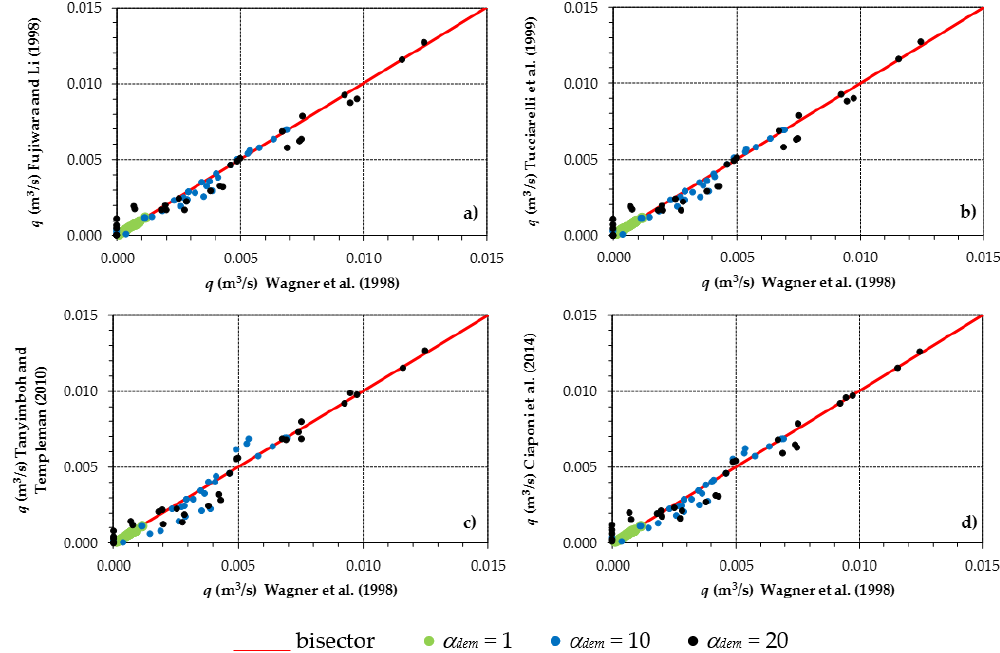
Figure 4. First case study. Comparison of the various formulations, ( a ) Fujiwara and Li [12], ( b ) Tucciarelli et al. [13], ( c ) Tanyimboh and Templeman [17] and ( d ) Ciaponi et al. [20], in terms of outflow q to users.